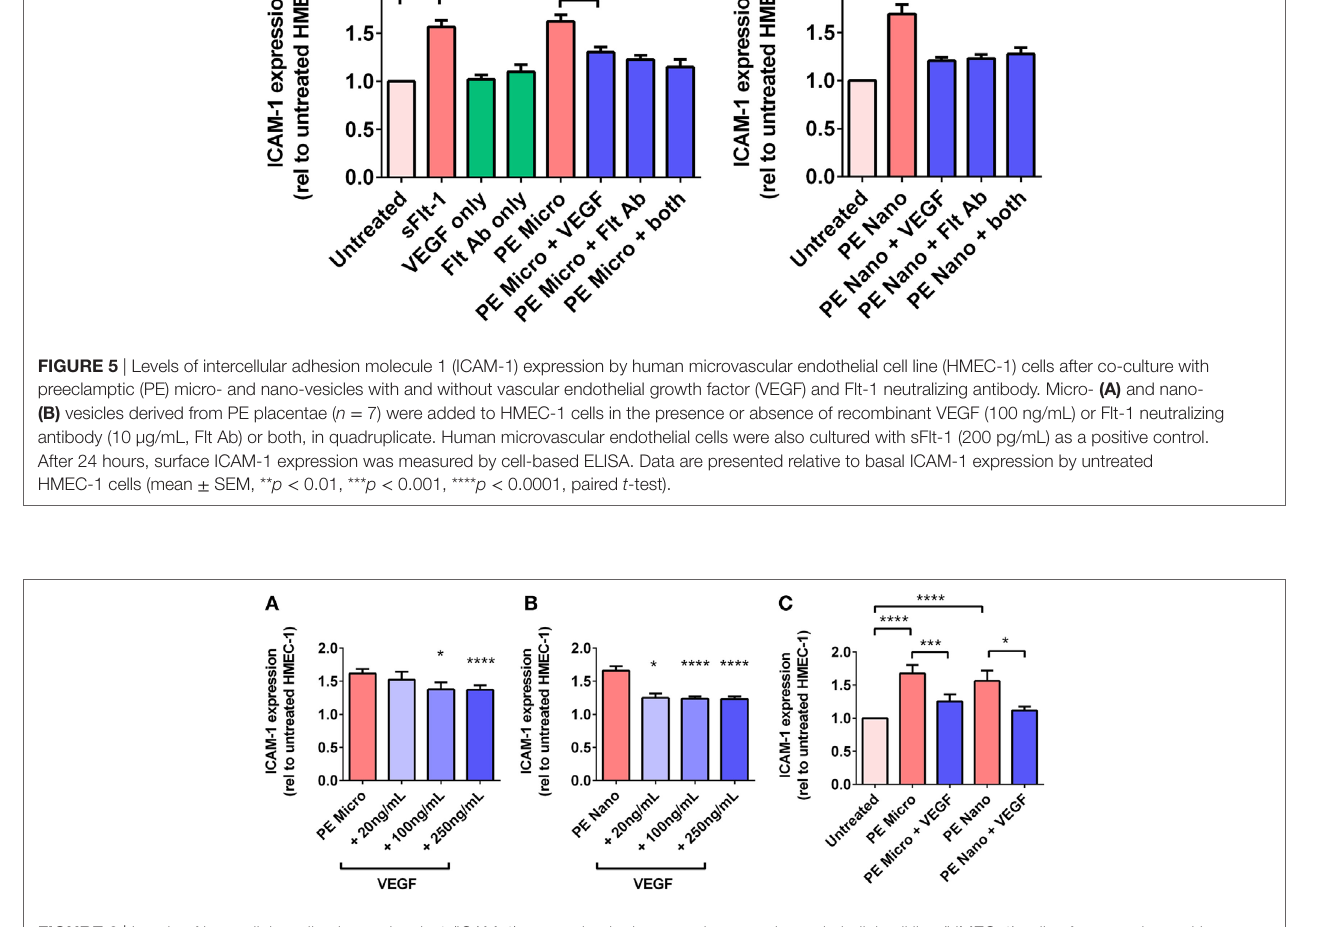
FigUre 6 | Levels of intercellular adhesion molecule 1 (ICAM-1) expression by human microvascular endothelial cell line (HMEC-1) cells after co-culture with preeclamptic (PE) micro- and nano-vesicles, in the presence of different VEGF treatment regimens. Human microvascular endothelial cells were cultured with PE micro- (a) or nano- (B) vesicles in the presence of 0, 20, 100, or 250 ng/mL exogenous VEGF, or PE vesicles that have been pretreated with 100 ng/mL VEGF prior to exposure to HMEC-1 (c) . After 24 h, surface expression of ICAM-1 was quantified and normalized to basal ICAM-1 levels expressed by untreated HMEC-1 cells (mean ± SEM, * p < 0.05, *** p < 0.001, **** p < 0.0001, paired t -test).